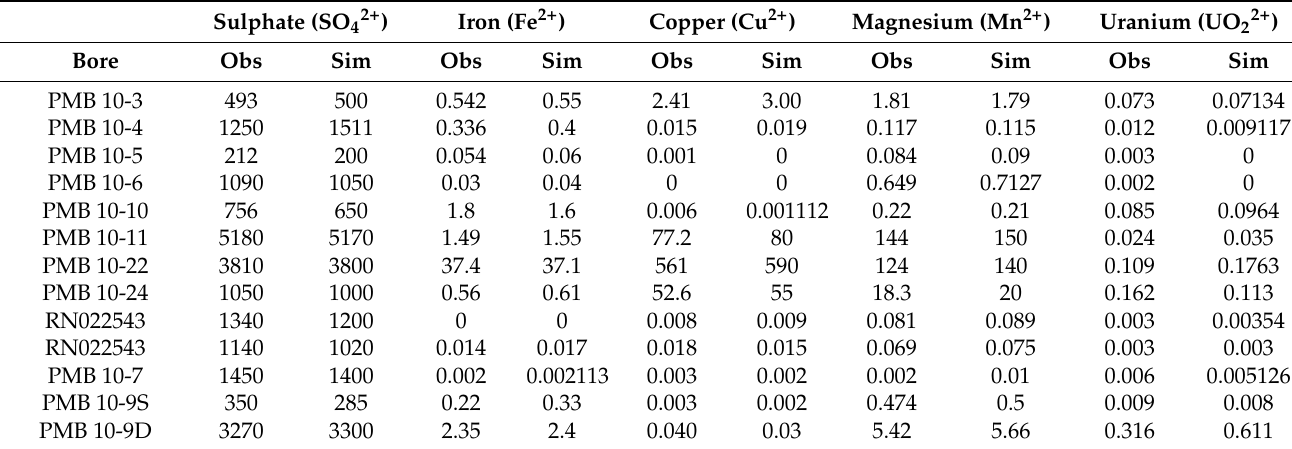
Table 8. Comparison of observed (Obs) and simulated (Sim) contaminant concentrations (mg/L) at monitoring locations based on final optimal sources from the source characterization